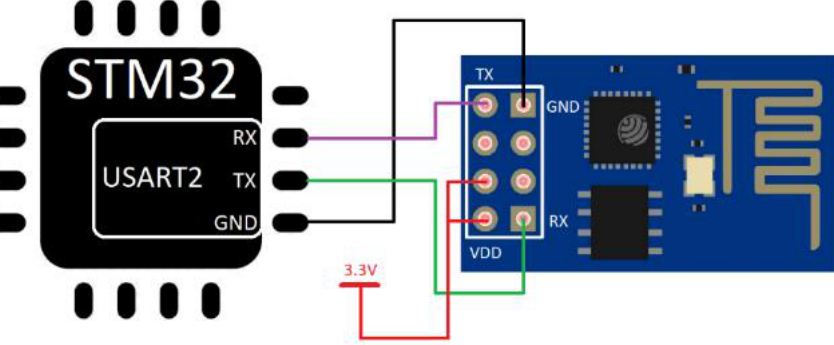
Figure 8. Monitoring STM32 microcontroller and esp8266 module connection via